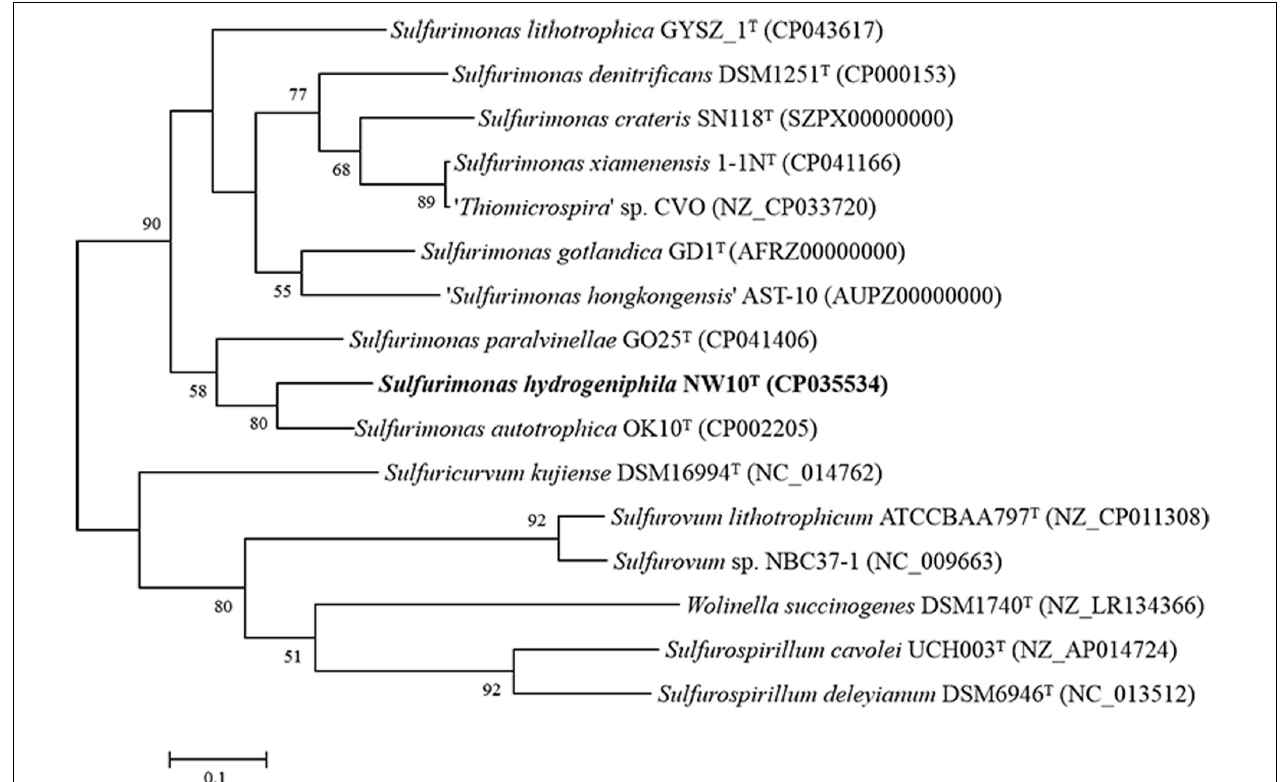
FIGURE 2 | Phylogenetic tree inferred using UBCGs showing the position of Sulfurimonas hydrogeniphila NW10 T and closely related taxa within the genus Sulfurimonas using the maximum-likelihood algorithm. The node is labeled with Gene Support Index (GSI) values. Branch node values below 50% are not shown. The accession numbers of the genomes are shown in parentheses. Bar, 0.1 substitutions per